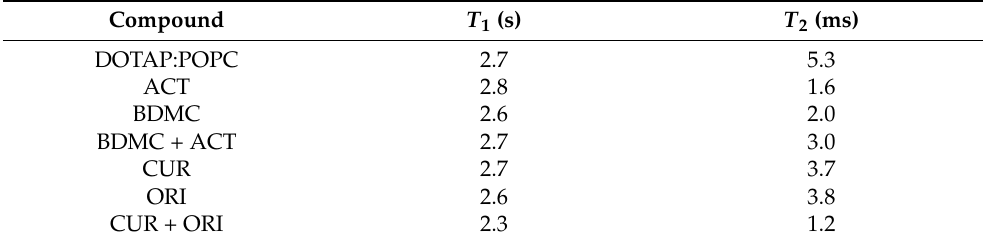
Table 2. Proton spin–lattice and spin–spin relaxation times for the tested liposomes.